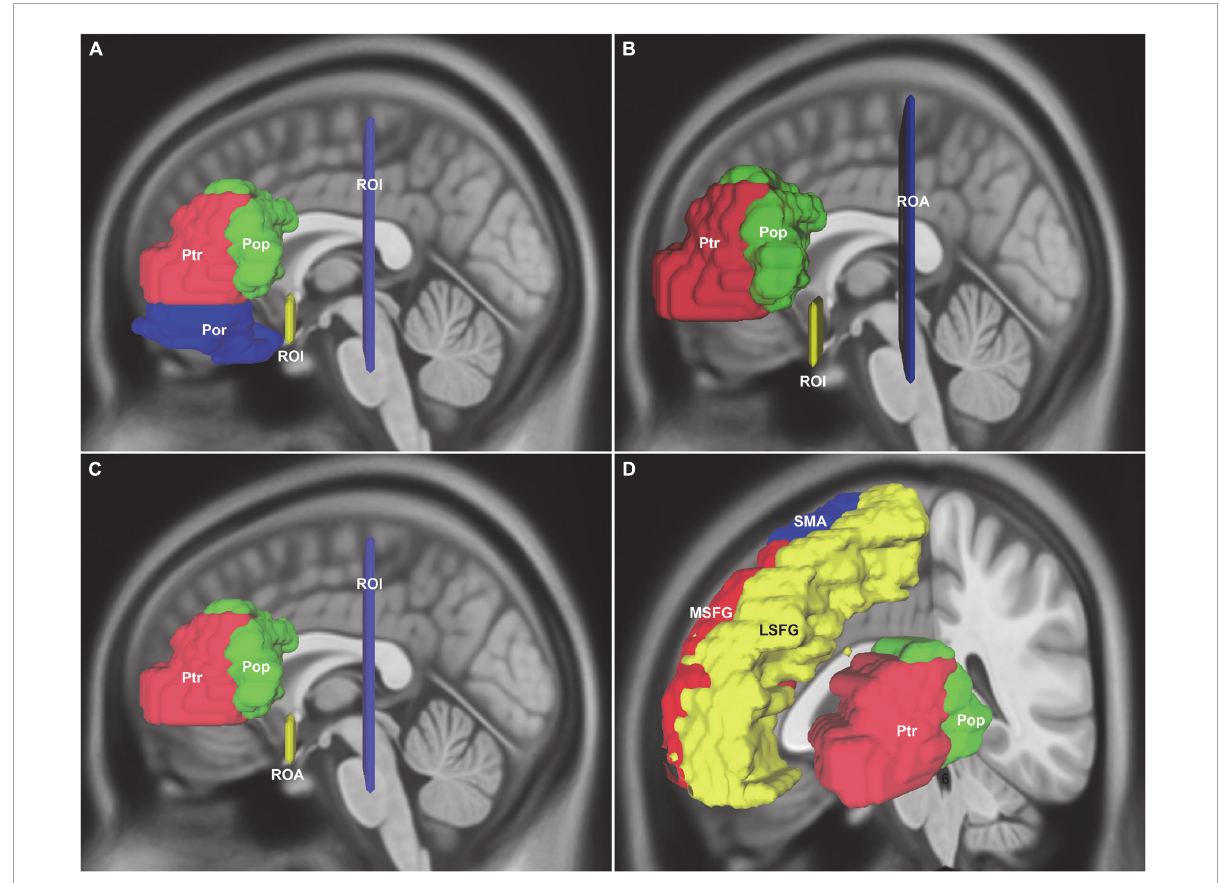
FIGURE1 In vivo fiber tractography of the IFOF, UF, AF, SLF-III, and FAT around the Broca’s region (HCP-842). (A) Reconstruction of the IFOF using two ROIs: one located around the ventral part of the external capsule on the coronal QA color map and the other was on the coronal plane at the level of the central sulcus. (B) Reconstruction of the UF: the same ROI was used from IFOF and the other ROI was changed to the ROA. (C) Reconstruction of the AF and the SLF-III: the external capsule ROI was changed to ROA, whereas the central sulcus ROI was used. (D) For the FAT connection, the ROI seed regions included the LSFG, MSFG, SMA, Ptr, and Pop. IFOF, inferior fronto-occipital fasciculus; UF, uncinate fasciculus; AF, arcuate fascicle; SLF-III, superior longitudinal fasciculus III; FAT, frontal aslant tract; Pop, pars opercularis; Ptr, pars triangularis; Por, pars orbitalis; LSFG, lateral superior frontal gyrus; MSFG, medial superior frontal gyrus; SMA, supplementary motor area; ROI, regions of interest; ROA, region of